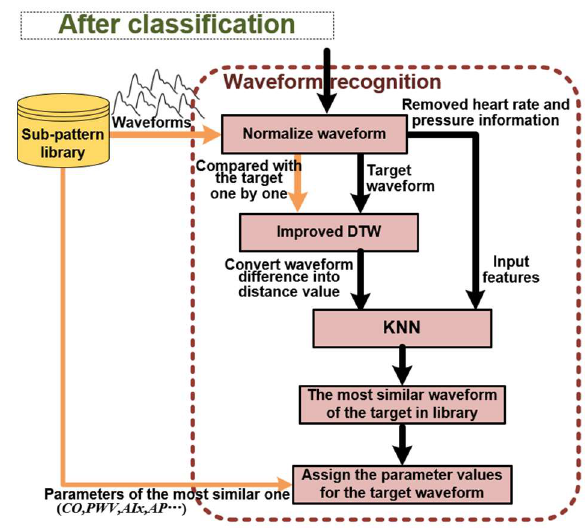
Figure 8. Waveform recognition process.